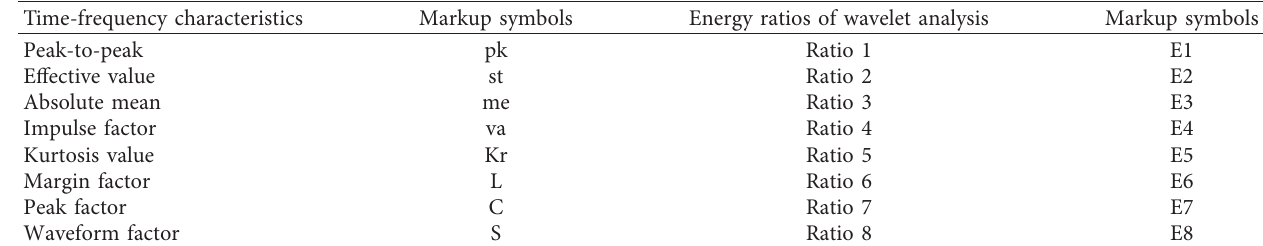
Figure 8: Vibration Table 2: Characteristic parameters.